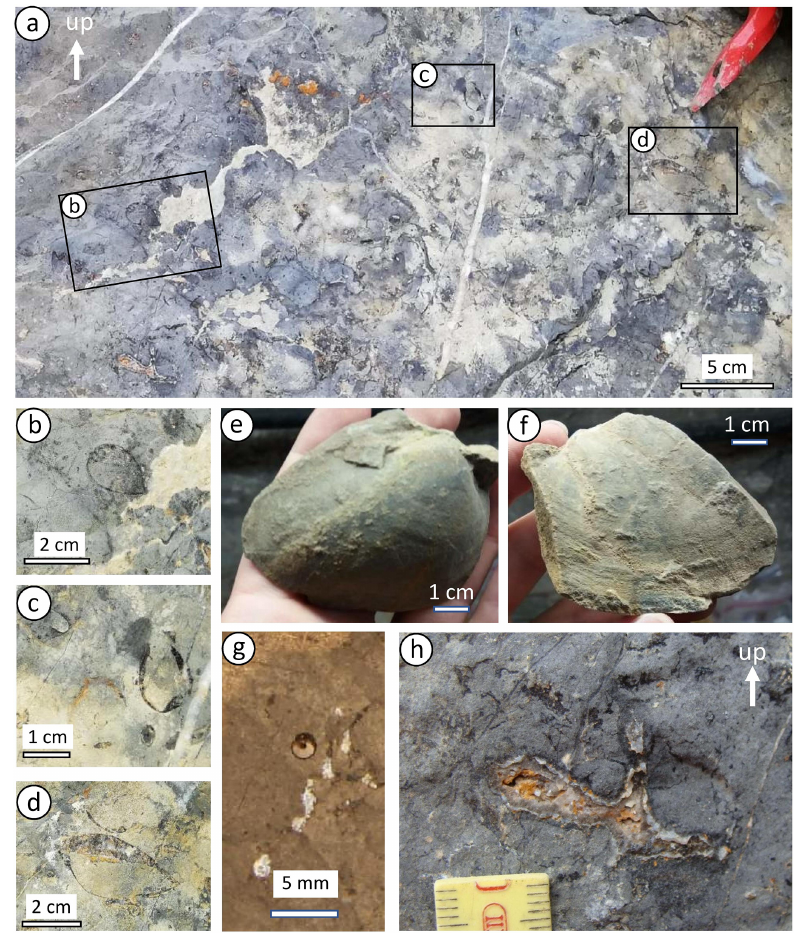
Figure 7. Facies 4 (F4): massive limestone and associated fauna. (a) Weathered surface showing three bivalves shown in (b) to (d) in detail, apparently belonging to different species. (d) Bivalve with geopetal filling. (e, f) Two valves of the only lucinid found (likely Beauvoisina carinata ; Kiel et al., 2010). (g) Section of a small gastropod. (h) Bedding plane view of Thalassinoides (smaller graduations on the tape measure are 1mm